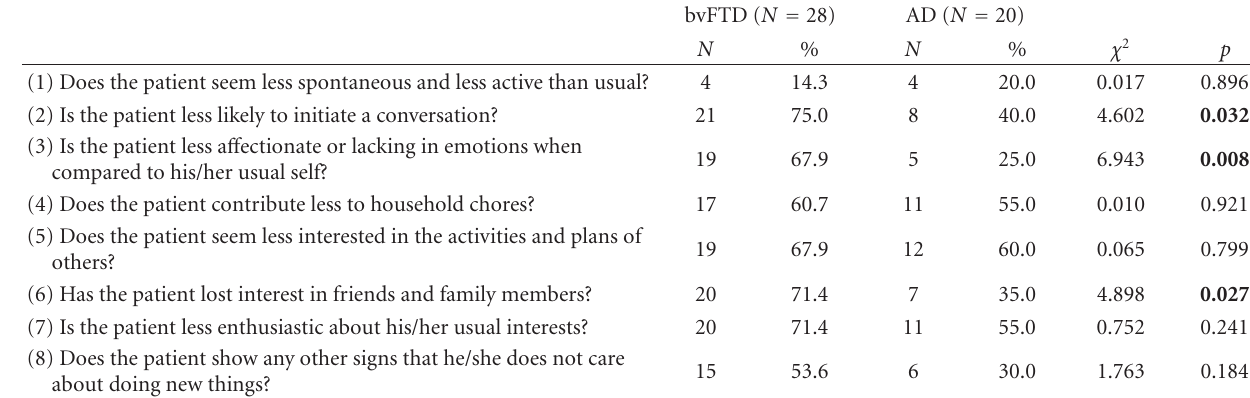
Table 3: Phenomenological features of apathy among FTD and AD subjects. Statistically significant di ff erences are indicated in